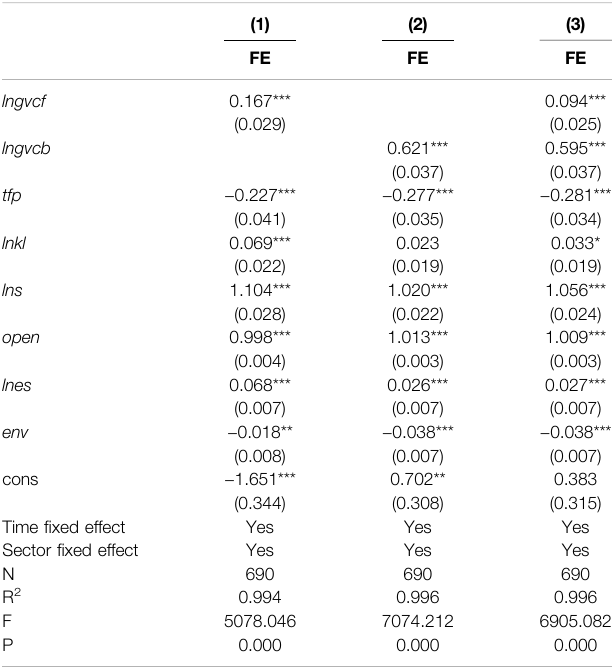
TABLE 3 | Baseline regression